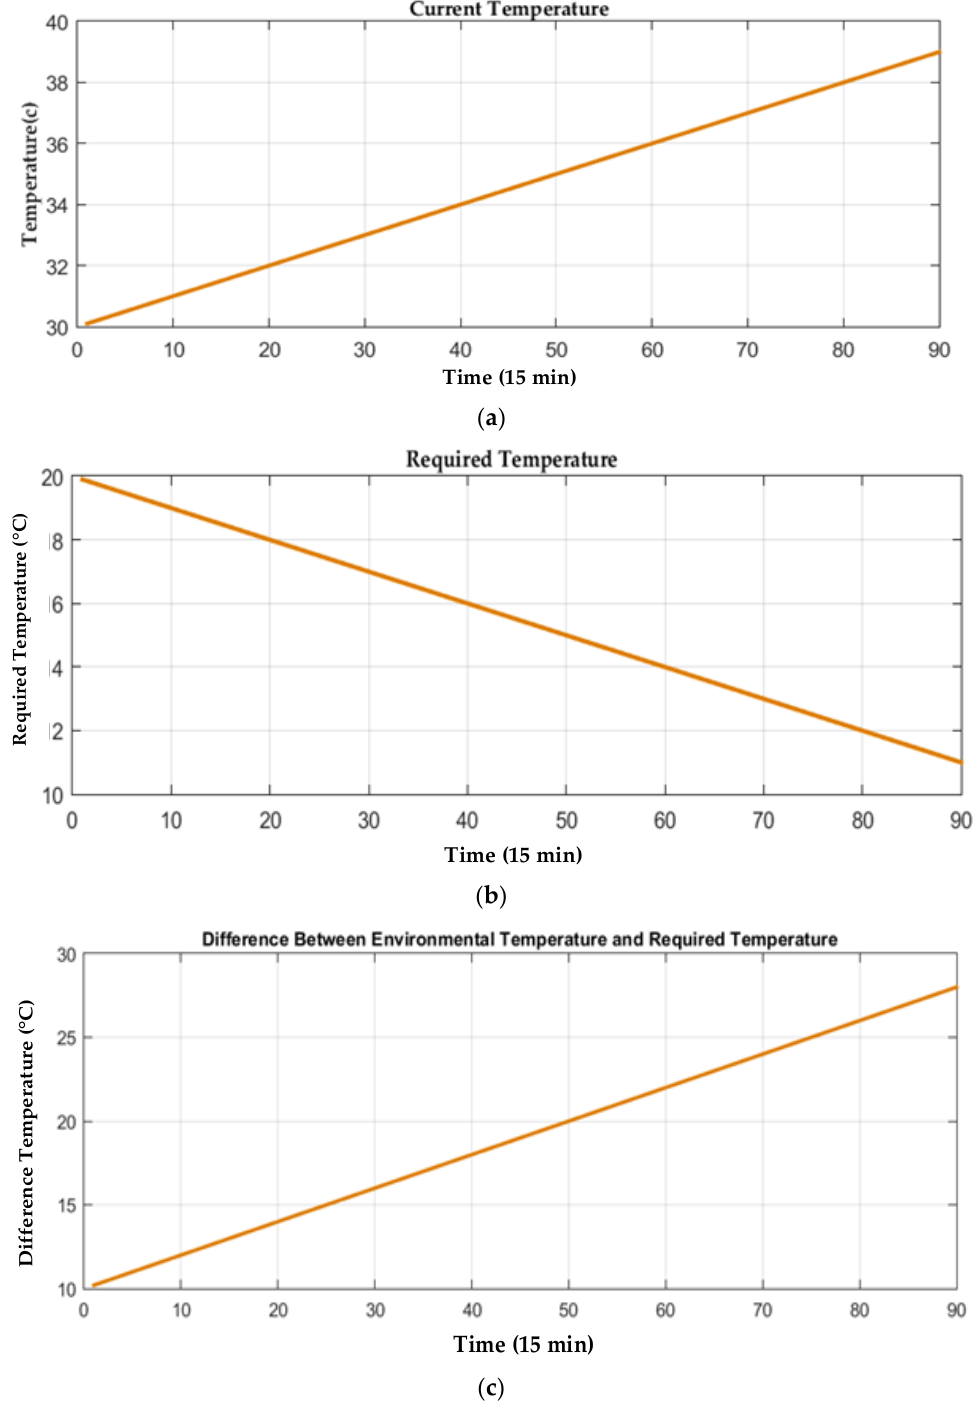
Figure 8. ( a ) Current temperature, ( b ) required temperature, and ( c ) the error difference between the current temperature and the required temperature.